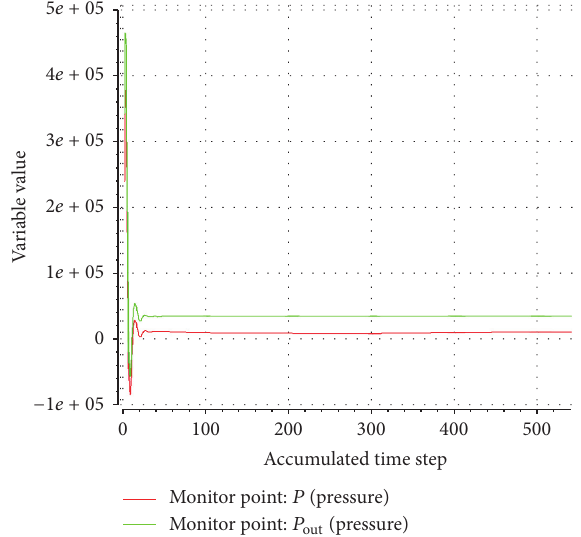
Figure 4: Convergence curves for monitors (mesh case 1 to 5).